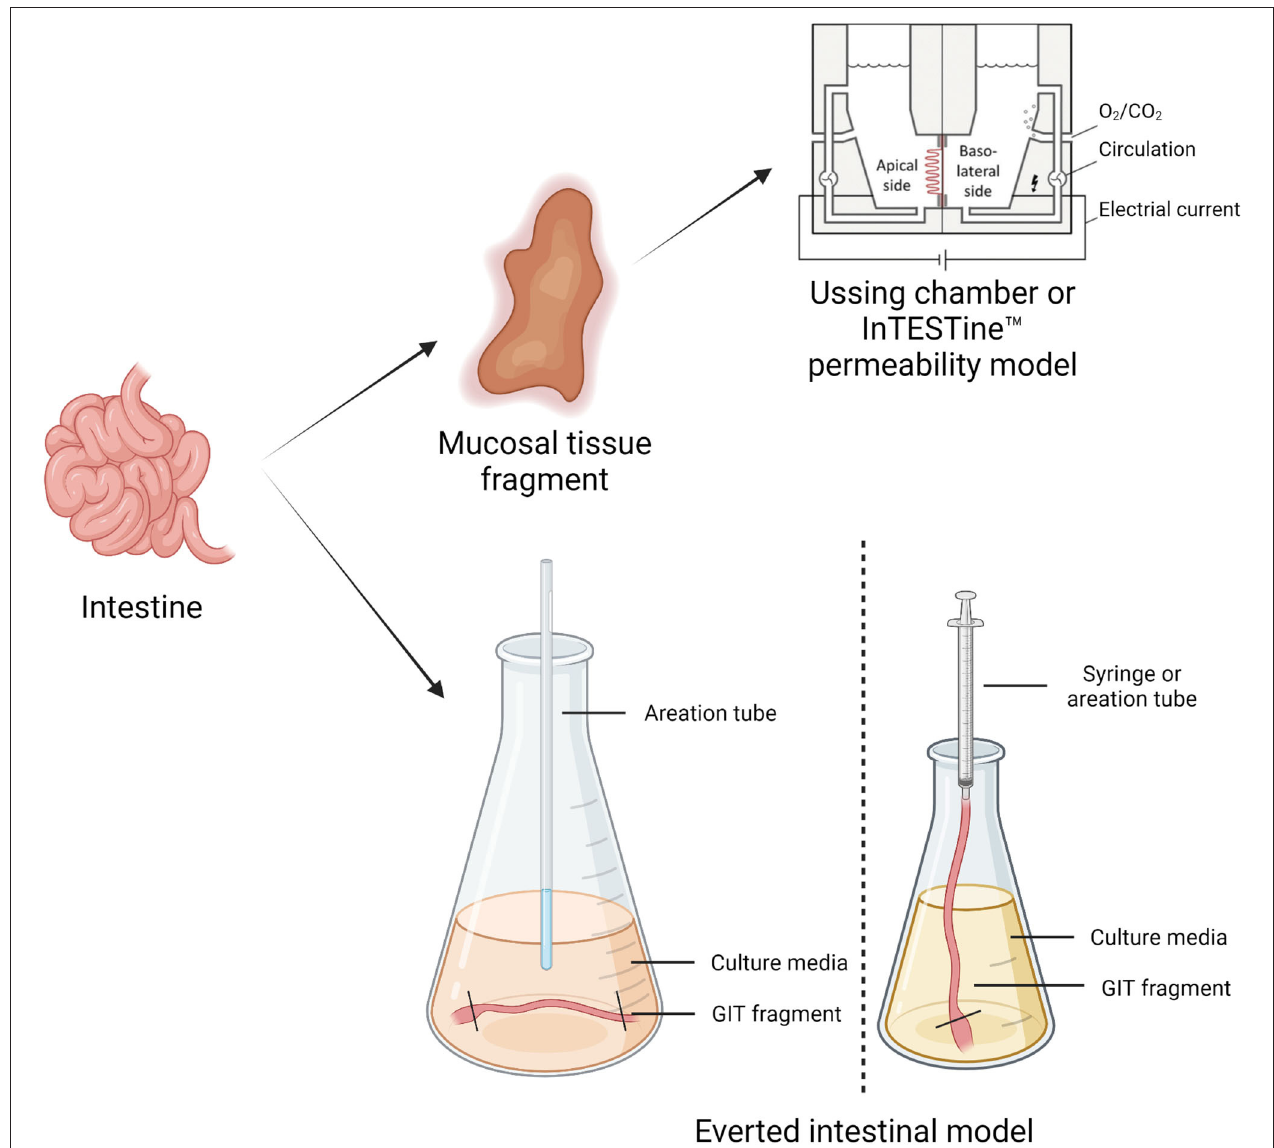
FIGURE 2 | The figure represents the different ex vivo models. The Using chamber or the inTESTine TM system works by removing a segment of intestinal mucosa from an animal, which is then mounted between two halves of a chamber filled with physiological buffer to simulate the mucosal and basolateral passage flow. In everted intestinal rings, the animal’s intestine is cut into ring slices and transferred into oxygenated culture media. This model is a useful tool for investigating uptake into intestinal cells and metabolism in different regions of the intestine—Created with